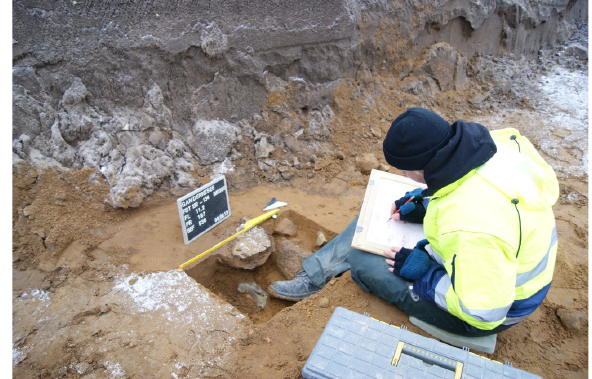
Figure 7: Conventional methods to record excavation sites in- clude, hand drawings, manual measurement and archaeological notes.